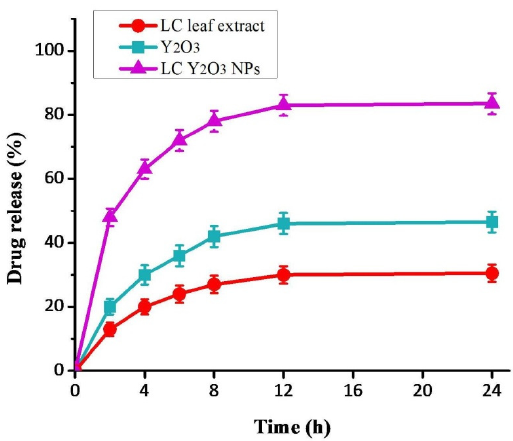
Figure 7. In vitro release of optimized LC Y 2 O 3 NPs. The drug shows rapid NPs release and aqueous drug solution. Around 85% of the drug was released in the first 30 min of the study. A saturation status was then observed in the drug release. On the other hand, optimized LC Y 2 O 3 NPs showed a more controlled drug release pattern than LC leaf extract and Y 2 O 3 NPs.